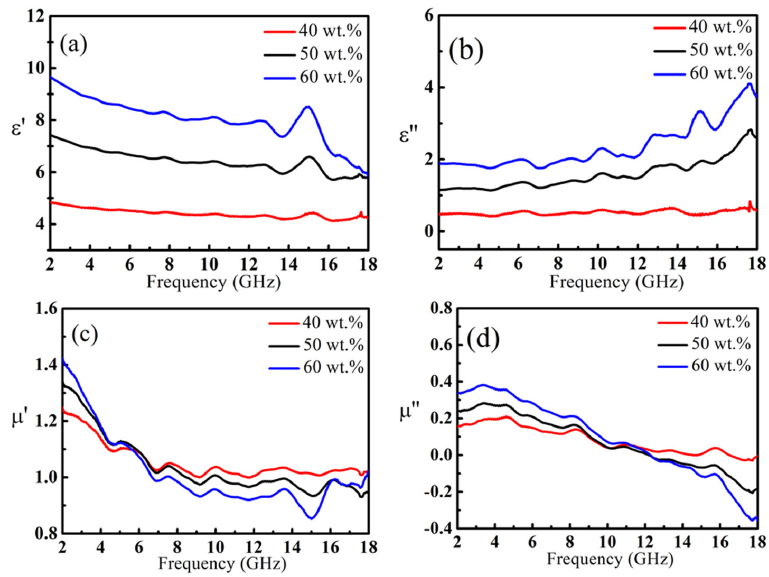
Figure 5. The ε (cid:4593) ( a ), ε (cid:4593)(cid:4593) ( b ), μ (cid:4593) ( c ) and μ (cid:4593)(cid:4593) ( d ) of Ni@C/paraffin composites.